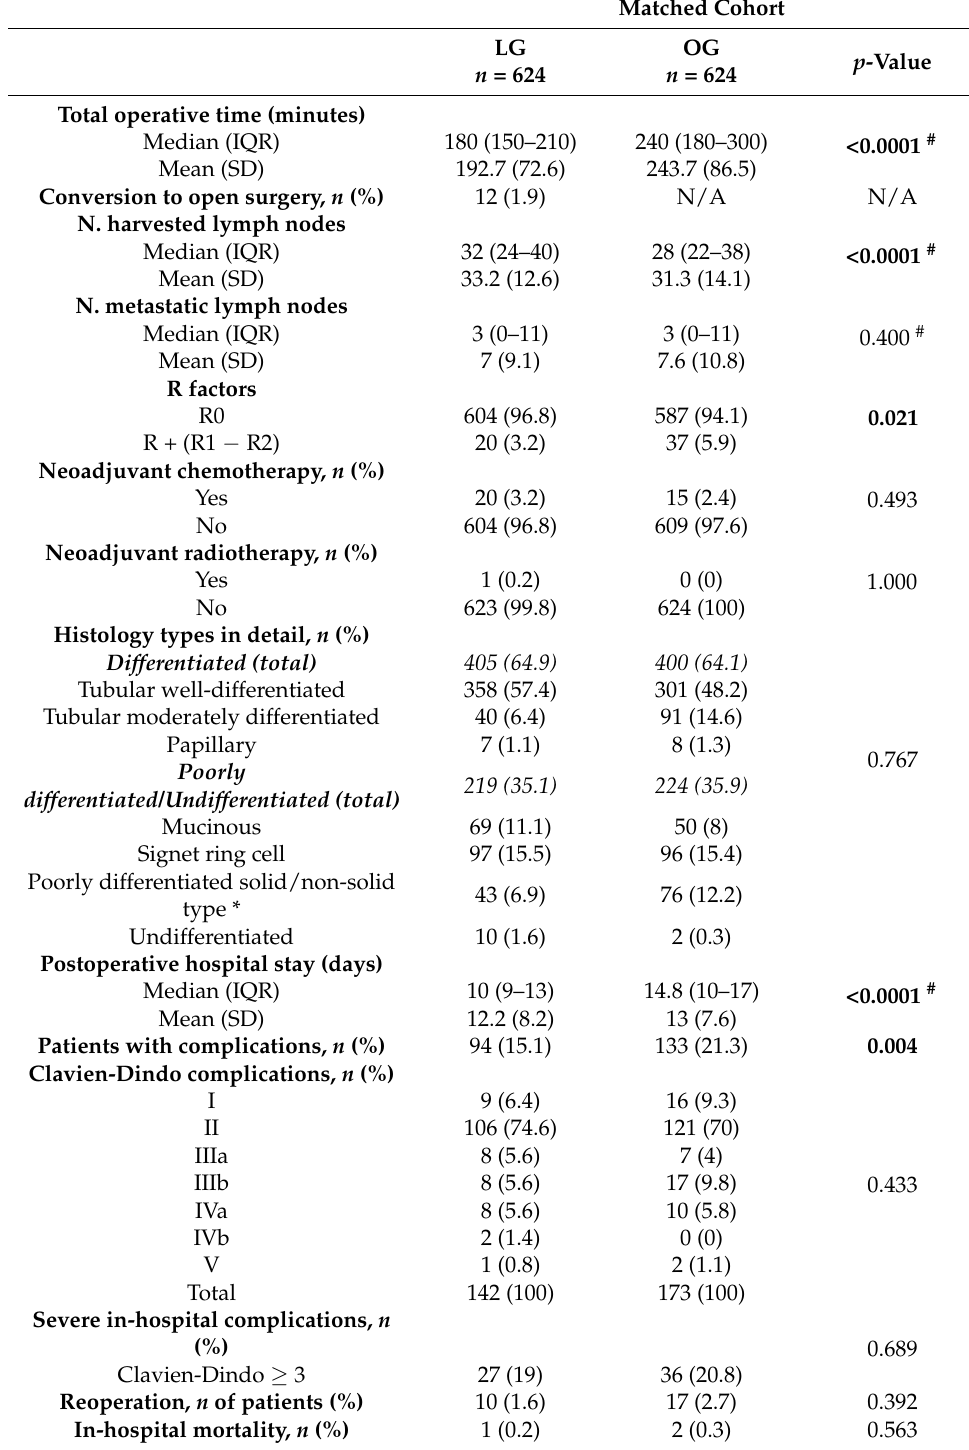
Table 2. Operating findings, postoperative complications, and pathology by surgical technique compared in the matched